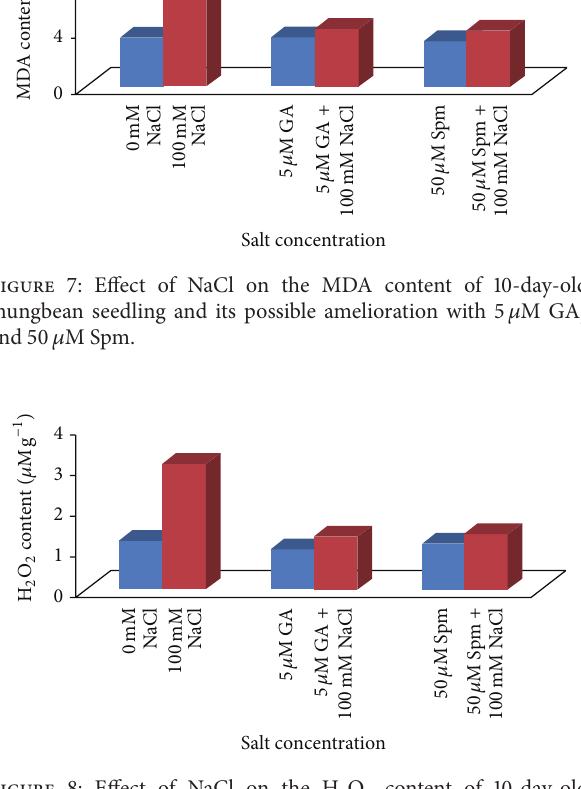
Figure 8: Effect of NaCl on the H 2 O 2 content of 10-day-old mungbean seedling and its possible amelioration with 5 𝜇 M GA 3 and 50 𝜇 M Spm.